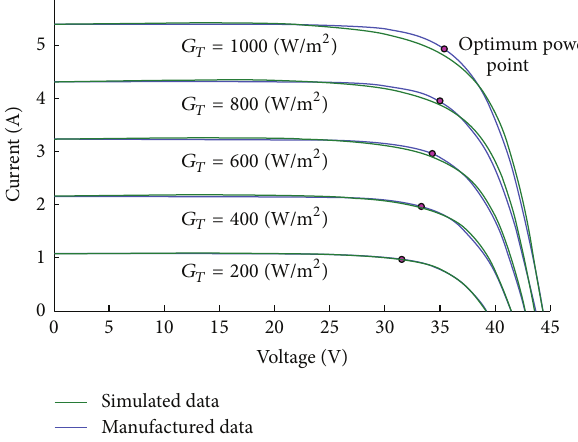
Figure 6: I-V characteristic curves for various set of solar radiation and